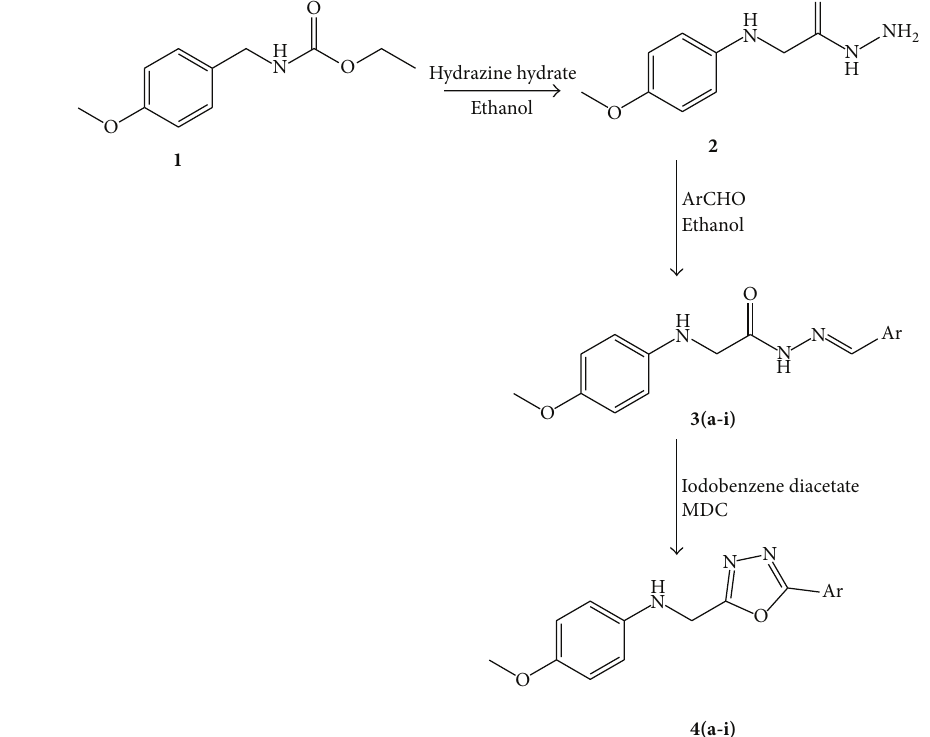
Scheme 1: Synthetic route for the target compounds 4(a–i)